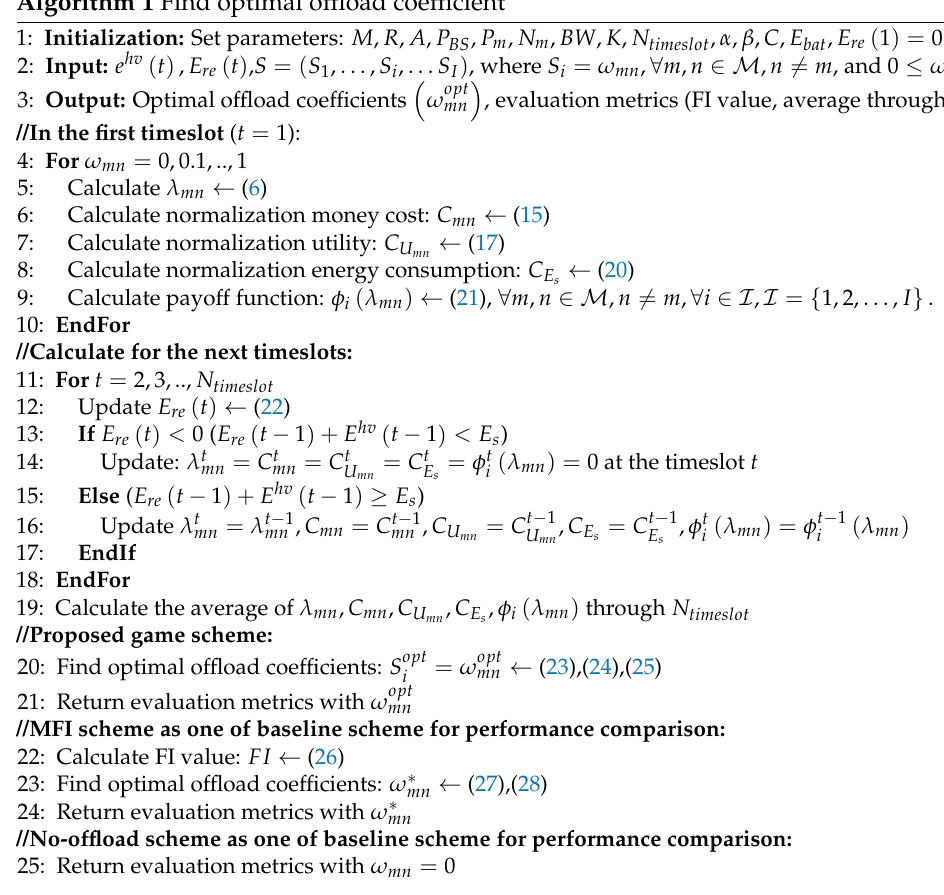
Algorithm 1 Find optimal offload